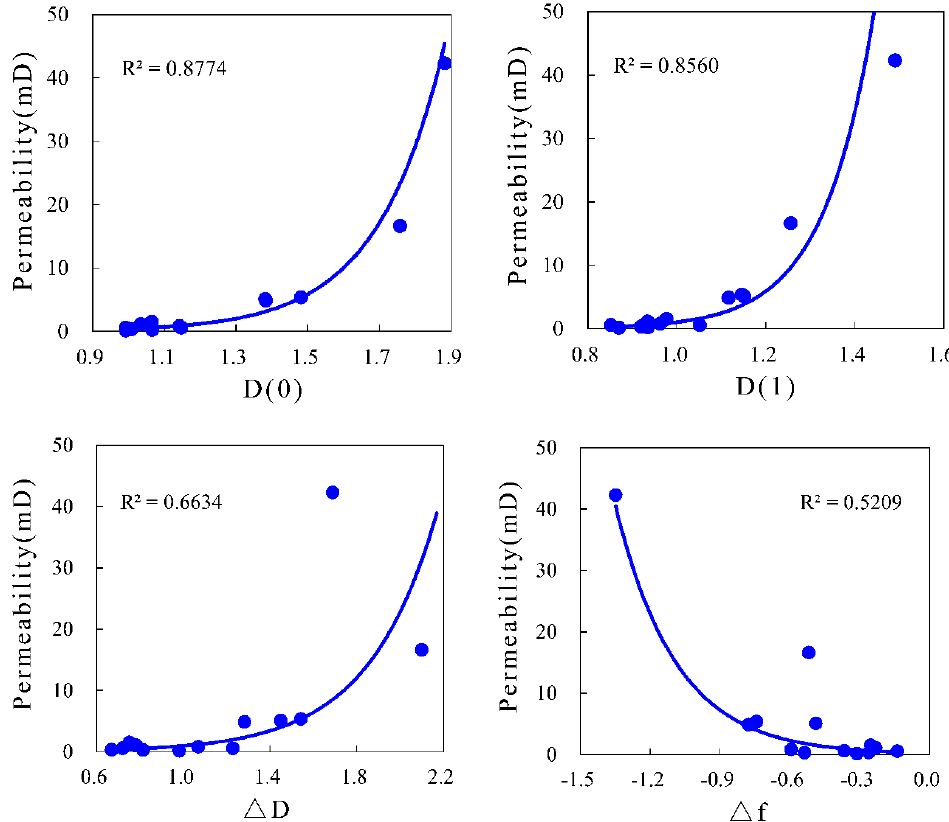
Figure 10. Plots of multifractal parameters and permeability.